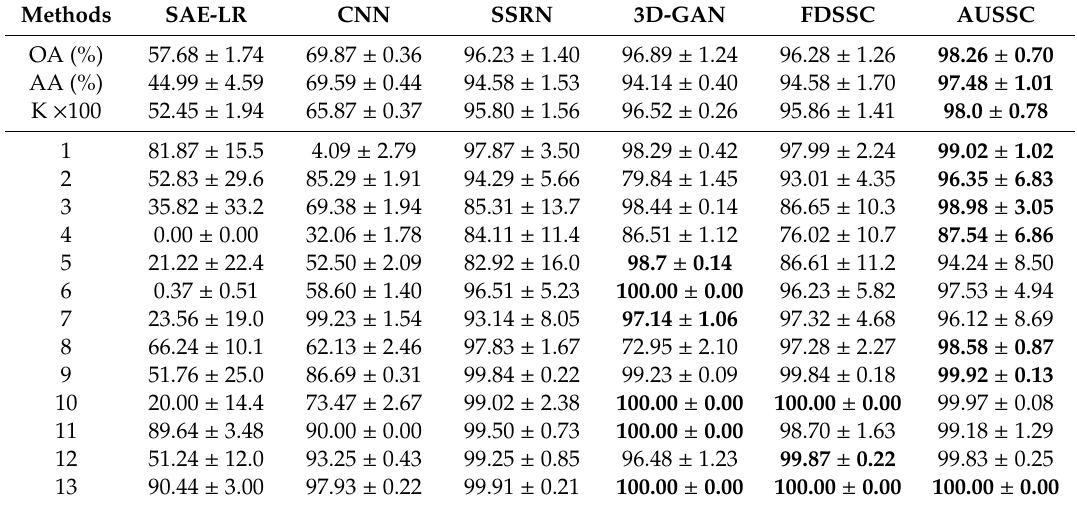
Table 5. OA, AA, K, and accuracy for each HSI category in the Kennedy Space Center (KSC) data set.